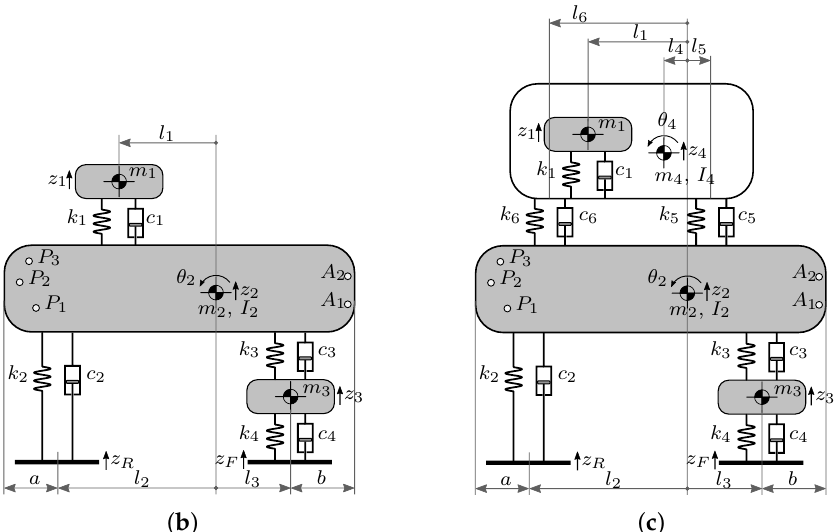
Figure 1. Lumped parameter models of different agricultural tractors: ( a ) a tractor with seat suspension; ( b ) a tractor with seat and front wheel suspension systems; ( c ) a tractor with seat, front wheel and cabin suspension